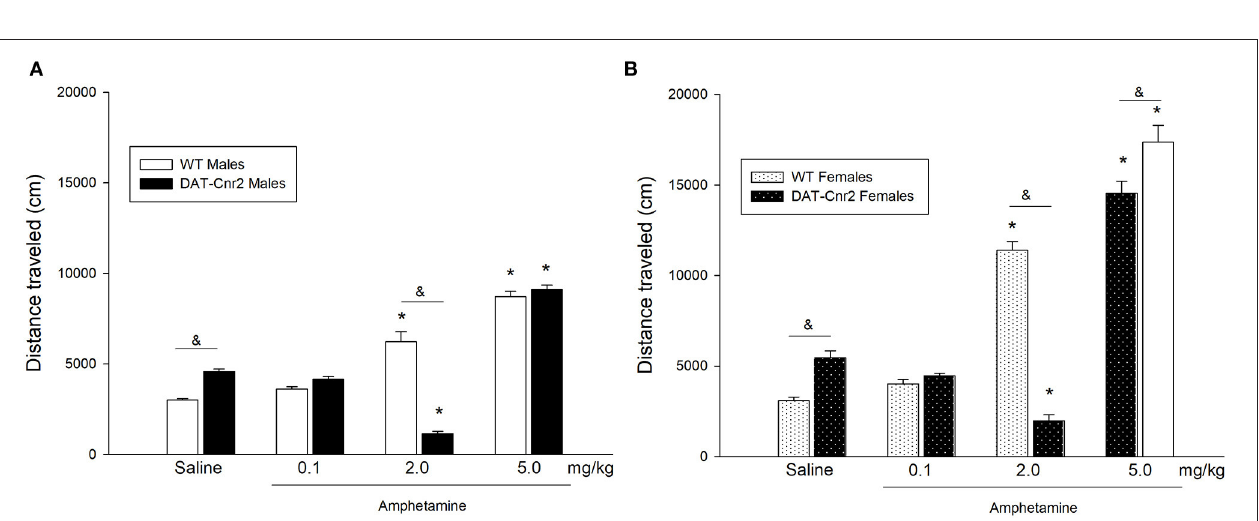
FIGURE 5 | Locomotor activity in adolescent DAT- Cnr2 cKO mice in response to different doses of amphetamine. Distance traveled in 30 min in the open field in response to 0.1, 2.0 and 5.0 mg/kg of amphetamine or its vehicle (saline). The white bars represent the WT and the black bars represent DAT-Cnr2 cKO mice. (A) males and in (B) females. Data are expressed as mean ± SEM ( n = 10 mice per group). Three-way ANOVA followed by Tukey post hoc test * p < 0.05 for treatment and & p < 0.05 for genotype.